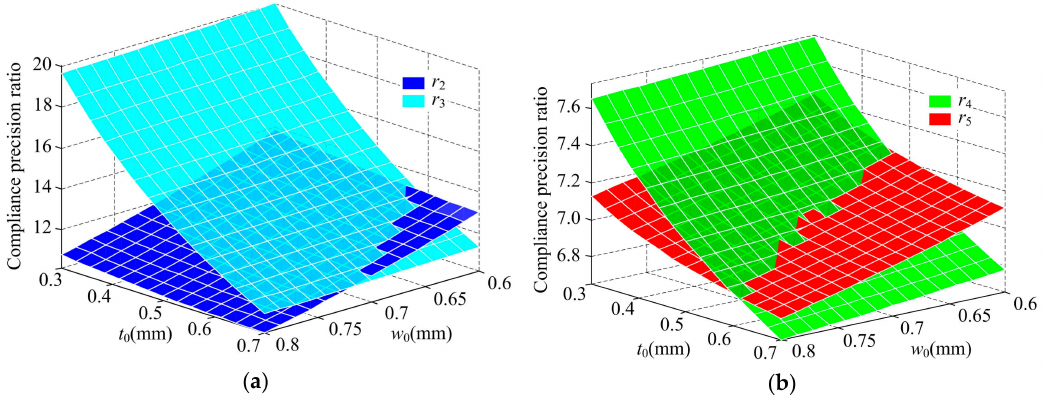
Figure 12. Compliance precision ratio of DEAF as a function of t 0 and w 0 : ( a ) translational; ( b ) cross.